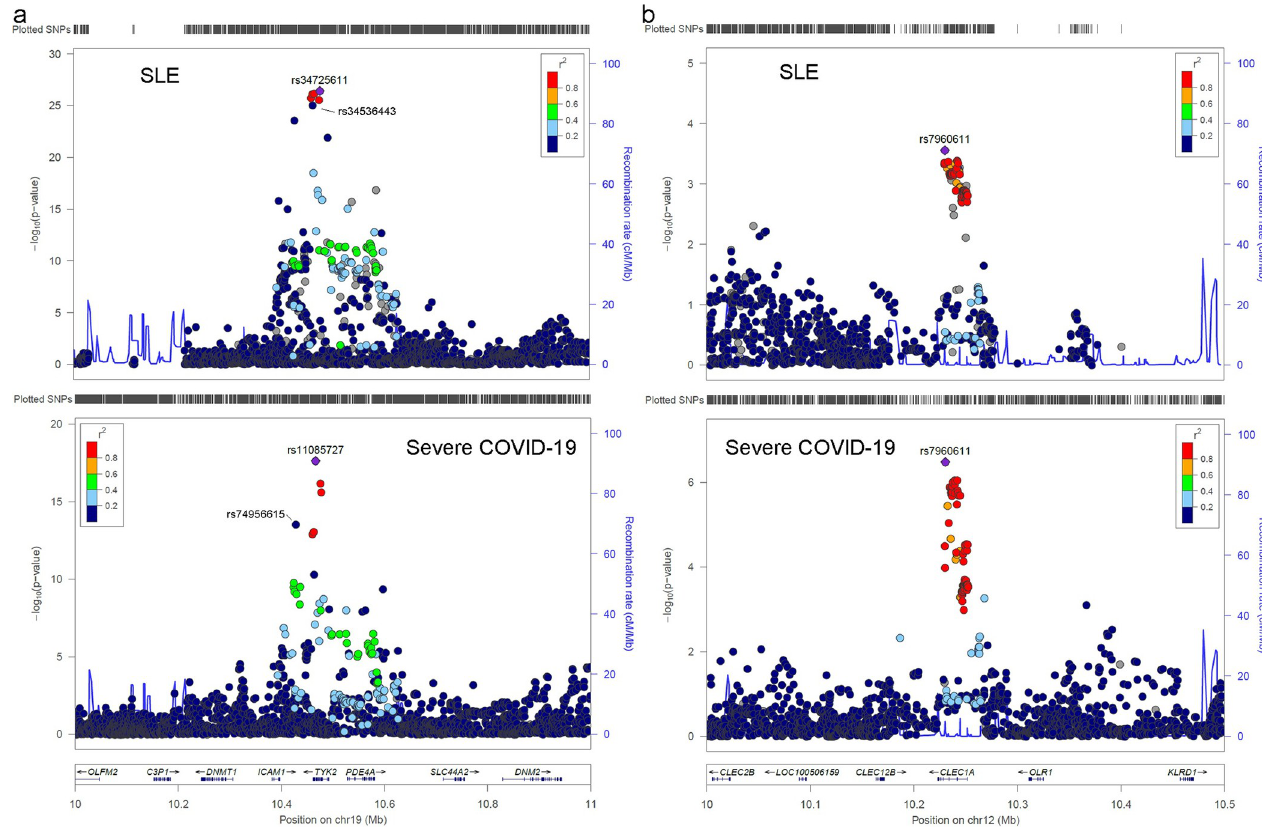
Fig 3. Locus zoom plots across a) TYK2 , b) CLEC1A for single marker associations with SLE, severe COVID-19. The LD (r 2 in 1000 Genome project Phase 3 EUR) is identified by